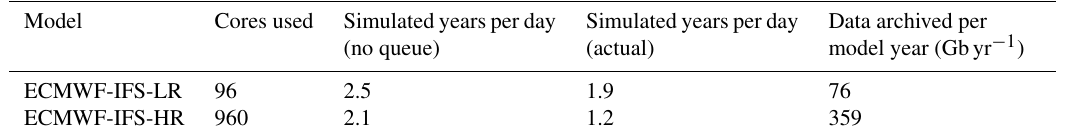
Table A1. Computational cost of coupled ECMWF-IFS configurations run on the ECMWF Cray XC40 with Intel Xeon EP E5-2695 V4 Broadwell processors.